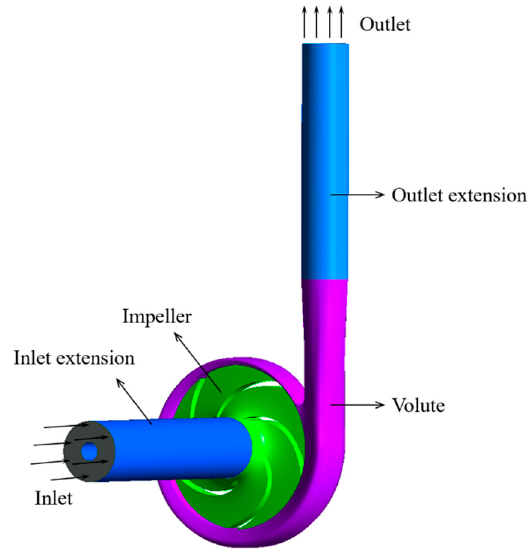
Figure 1. 3D geometry of the pump model. Table 1. Parameters of the pump